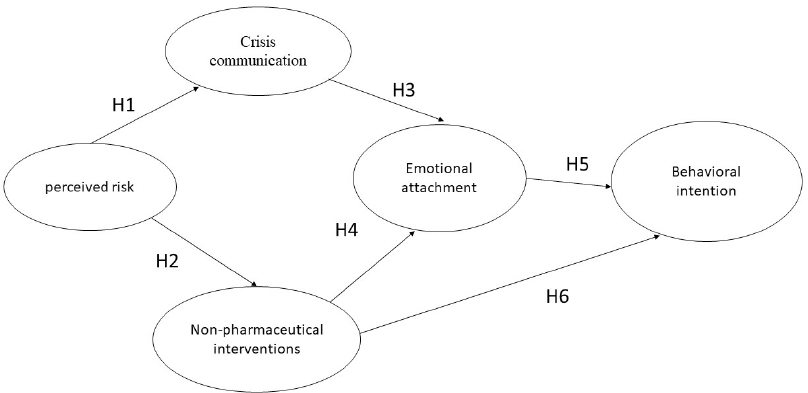
Figure 1. Research